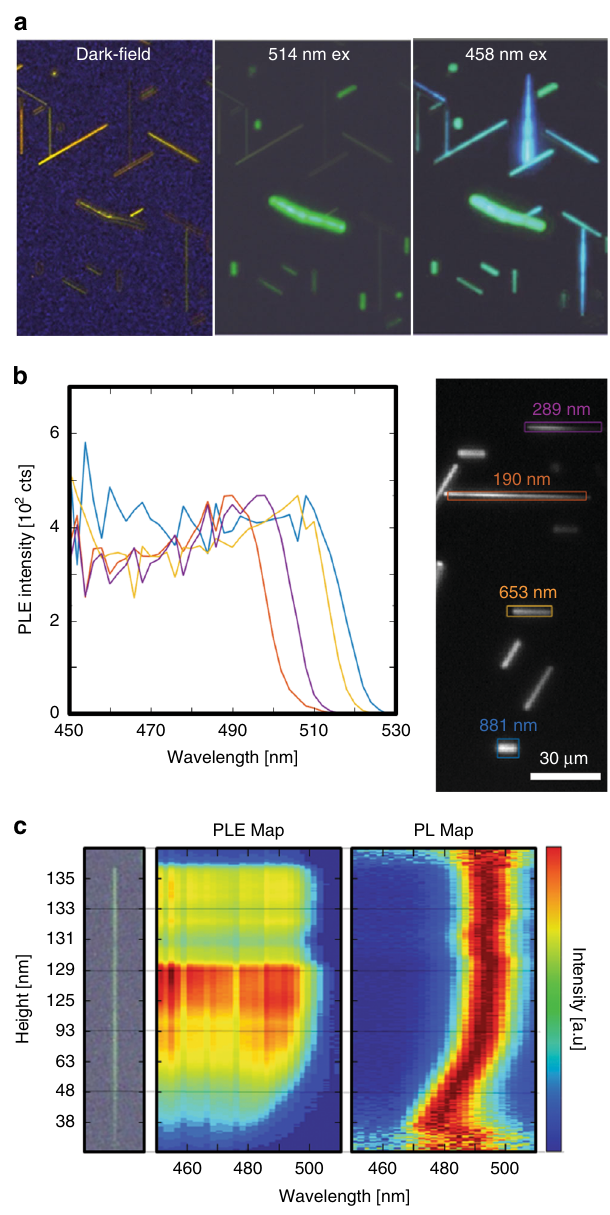
Fig. 3 Size-dependent PL-excitation spectra and excitation onset of CsPbBr 3 nanowires. ( a ) An ensemble of surface-guided CsPbBr 3 nanowires with different heights, with images showing a dark- fi eld image and PL images with 514 and 458nm excitation. ( b ) PLE spectra of structures with different heights. The colors of the lines correlate with the heights indicated by the same colors in the transmission image to the right of the plot. A blue-shift in emission excitation onset (sudden rise in PLE intensity upon decreasing the excitation wavelength) with decreasing height can be observed. ( c ) Normalized PL and PLE maps of a single tapered nanowire correlated with its height at each position. Both the peak emission wavelength (PL map) and emission onset wavelength (PLE map) show orchestrated blue-shifts with decreasing height of the